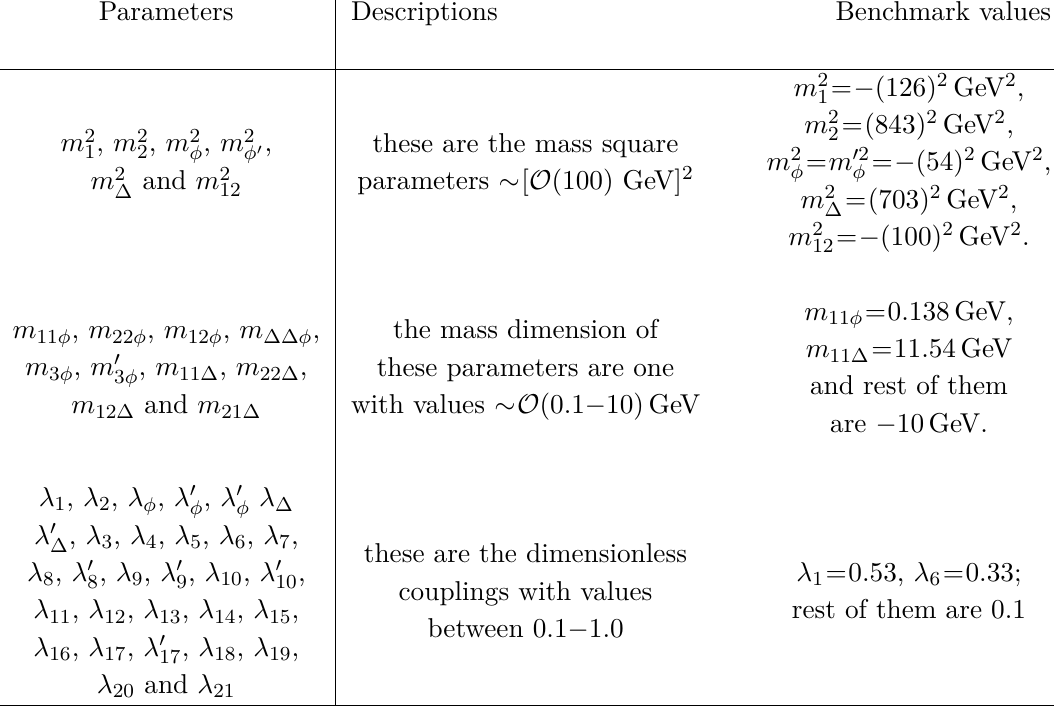
Table 1 . Brief descriptions and the necessary range of values for all the parameters that appear in the scalar potential in eq. (4.2). One particular benchmark scenario is shown. We use this benchmark to generate a light scalar of mass ∼ O (1) keV along with other heavy physical scalars consistent with the LHC bounds. The values of the vev’s are v and v = 1 ∆